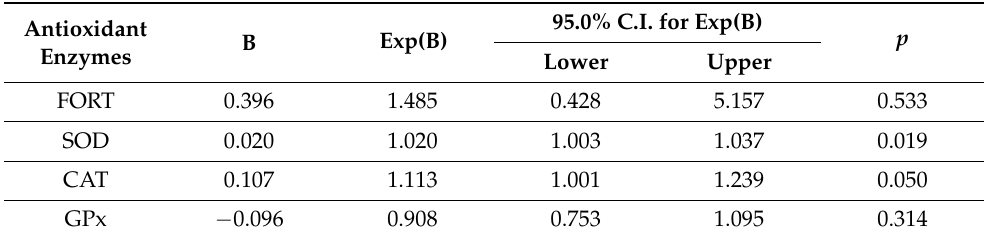
Table 6. Results of a multivariate logical regression analysis for predicting coronary artery atheroscle- rosis by the activity of antioxidant